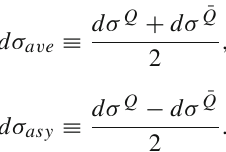
to be zero, i.e., y = 0 ,φ = 0. The uncertainty band is obtained by √ S = 200 and varying renormalization scale μ from E 1 ⊥ / 2 to 2 E 1 ⊥ . Note that in a , LO and NLO bands have an